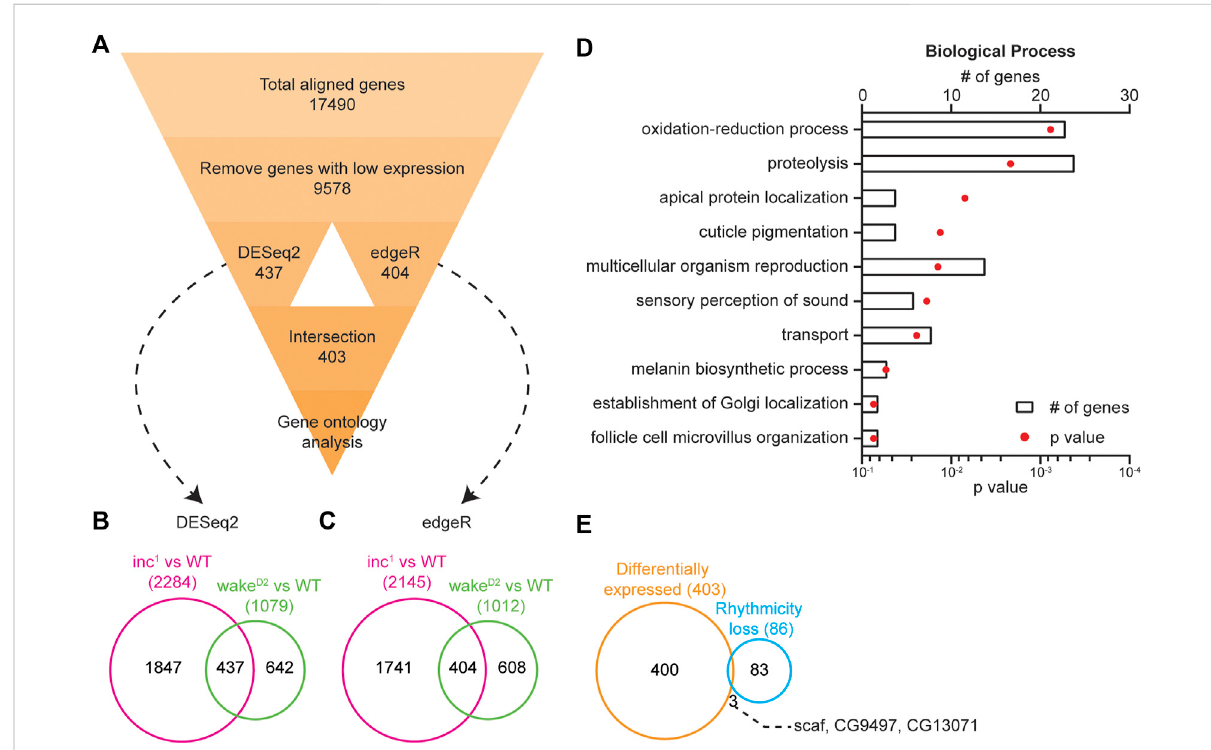
FIGURE 5 Loss of rhythmicity is not caused by differential expression. (A) Flowchart showing the pipeline for differential gene expression (DGE) analysis. Number in each box represents number of genes. (B) Intersection of differentially expressed genes identi fi ed by DESeq2 (Benjamini-Hochberg adjusted p < 0.05) in inc 1 (magenta) and wake D2 (green). (C) Intersection of differentially expressed genes identi fi ed by edgeR ( p < 0.05) in inc 1 (magenta) and wake D2 (green). (D) Enriched biological processes revealed by gene ontology analysis using 403 differentially expressed genes. Top 10 enriched biological pathways are shown. Bars represent number of genes and dots represent p -value. (E) Intersection of differentially expressed genes (orange) and loss of rhythmicity genes (cyan) in both inc 1 and wake D2 animals. The 3 intersected genes are